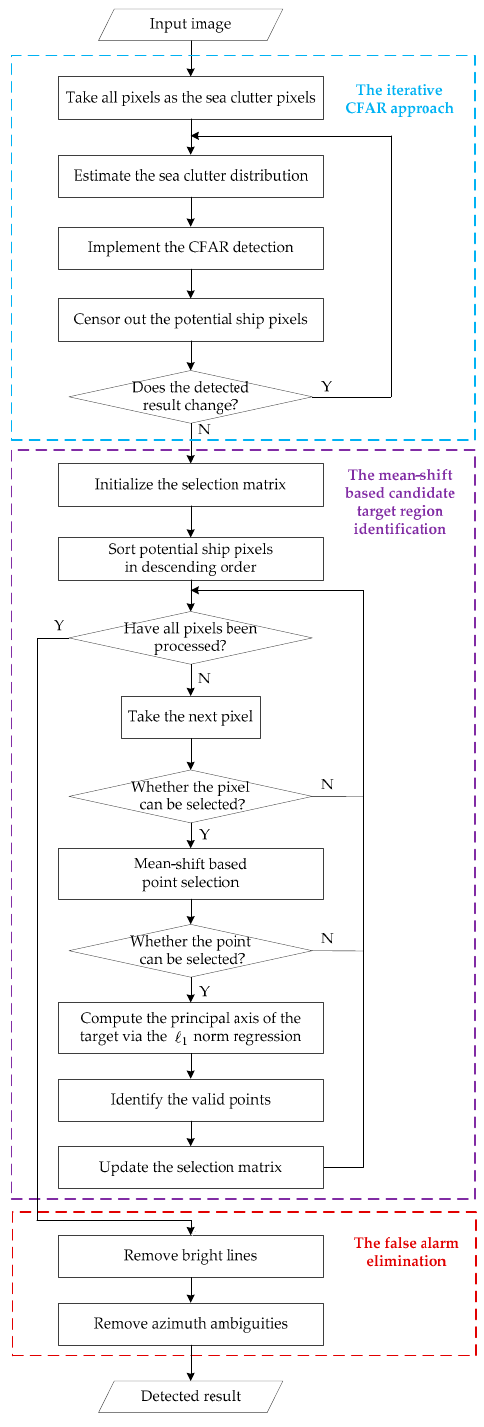
Figure 2. Workflow of the proposed method.